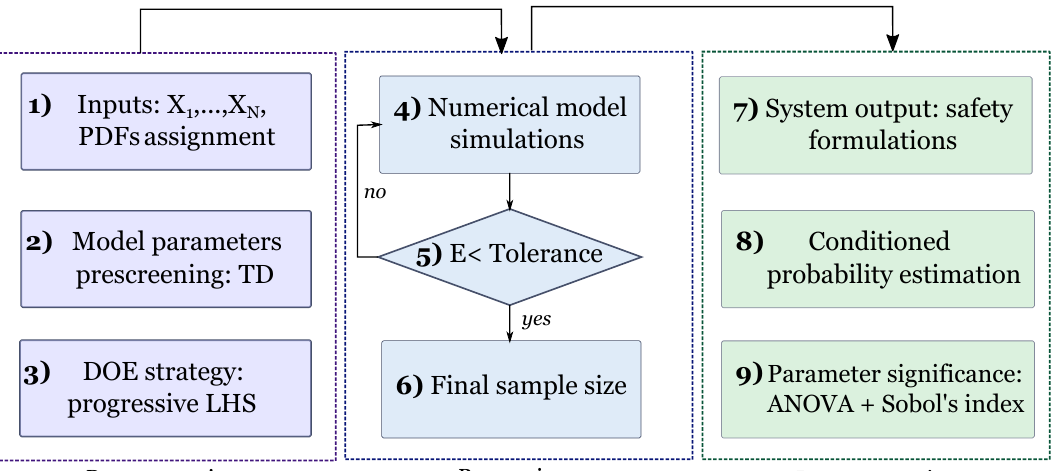
Figure 1. Probabilistic-based